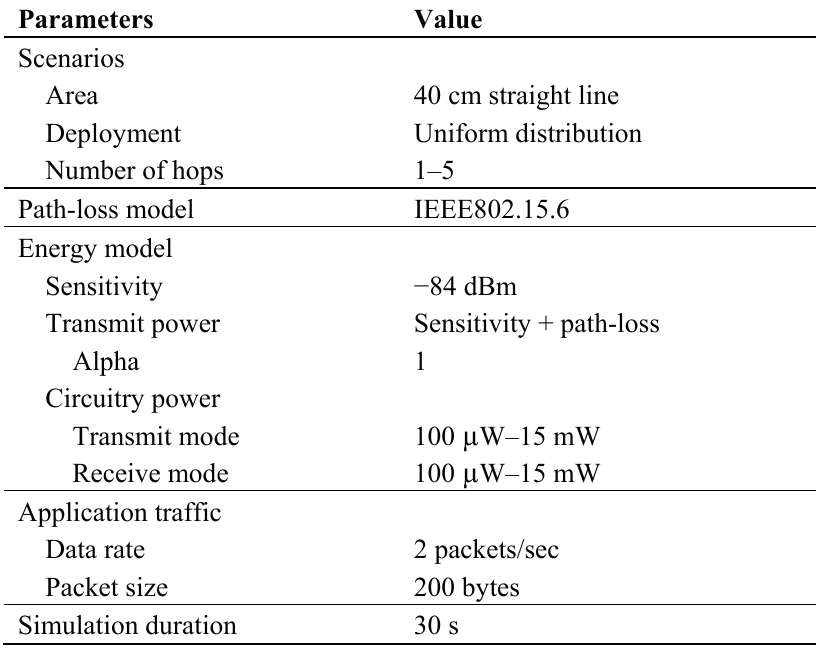
Table 2. Simulation parameters for the evaluation of multi-hop